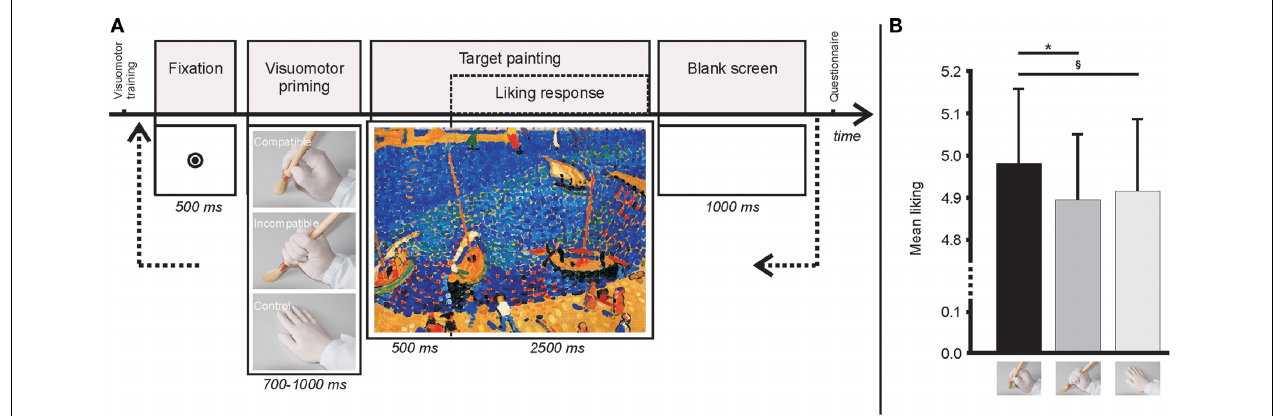
FIGURE 2 | (A) Images of a gloved-hand holding a paintbrush were used as supraliminal priming before the display of each pointillist-style painting. The images consisted of either a precision or a power grip, or of a rested palm down hand and they created three conditions. Compatible (precision grip) or Incompatible (power grip) with the drawing of pointillist-style paintings. The palm down image served as Control . (B) The preference expressed when the paintings were